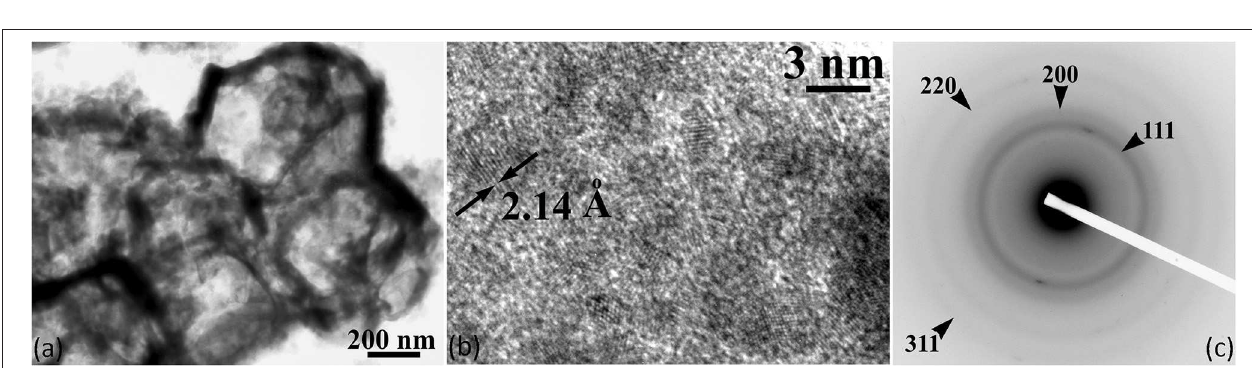
FIGURE 3 | (a) TEM micrographs illustrating the core-shell morphology of the Cu 2 O@P(BA-b-AA) microcapsules, (b) HRTEM image of the atomic structure of the core nanocrystalline phase; the 2.14 Å interplanar spacing of the crystal planes of Cu 2 O is clearly resolved, (c) the diffuse rings of the corresponding SAED pattern are characteristic of a nanocrystalline material. The {111}, {200}, {220}, and {311} reflections of Cu 2 O are clearly